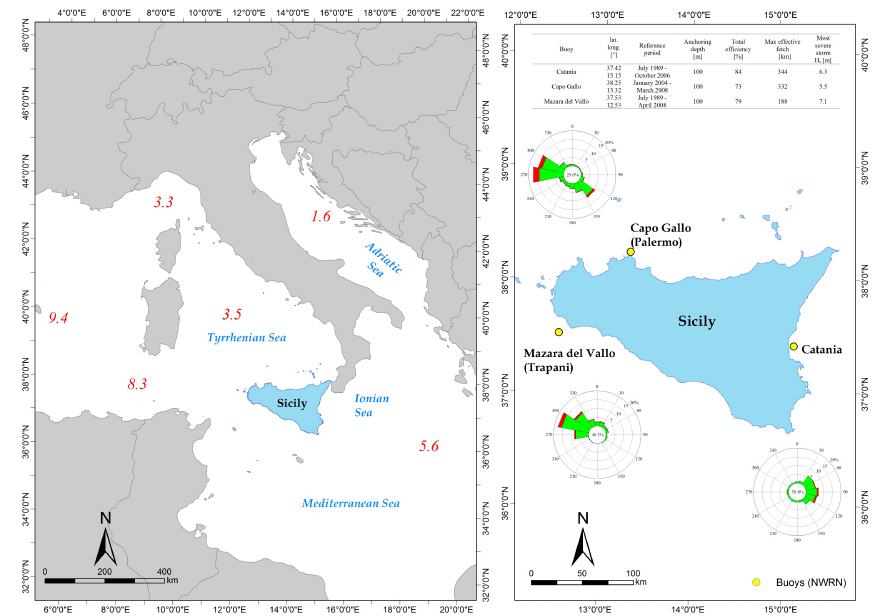
Figure 1. Location of study area. The red values in the left picture indicate the yearly mean wave power flux (in kWm − 1 ) estimates by ECMWF